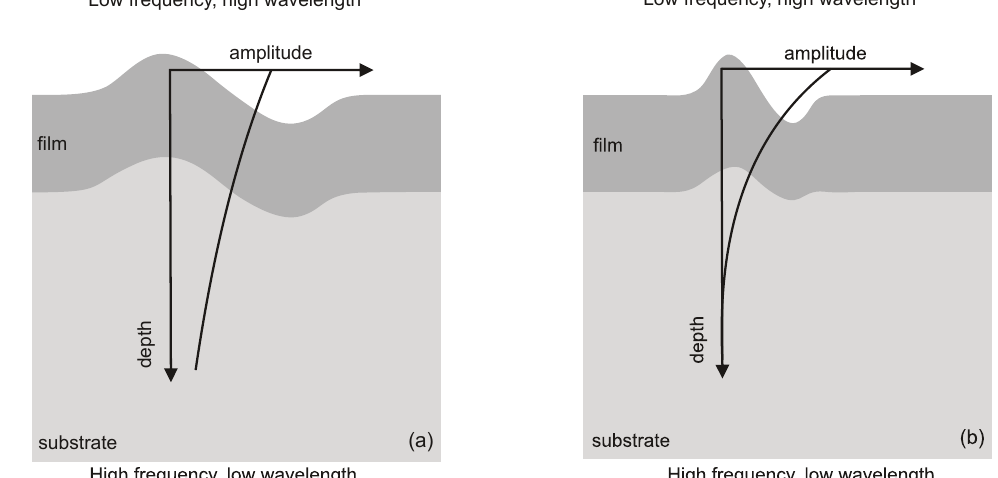
Figure 1. Propagation and amplitude-decay of SAW with a) low frequency and b) high frequency